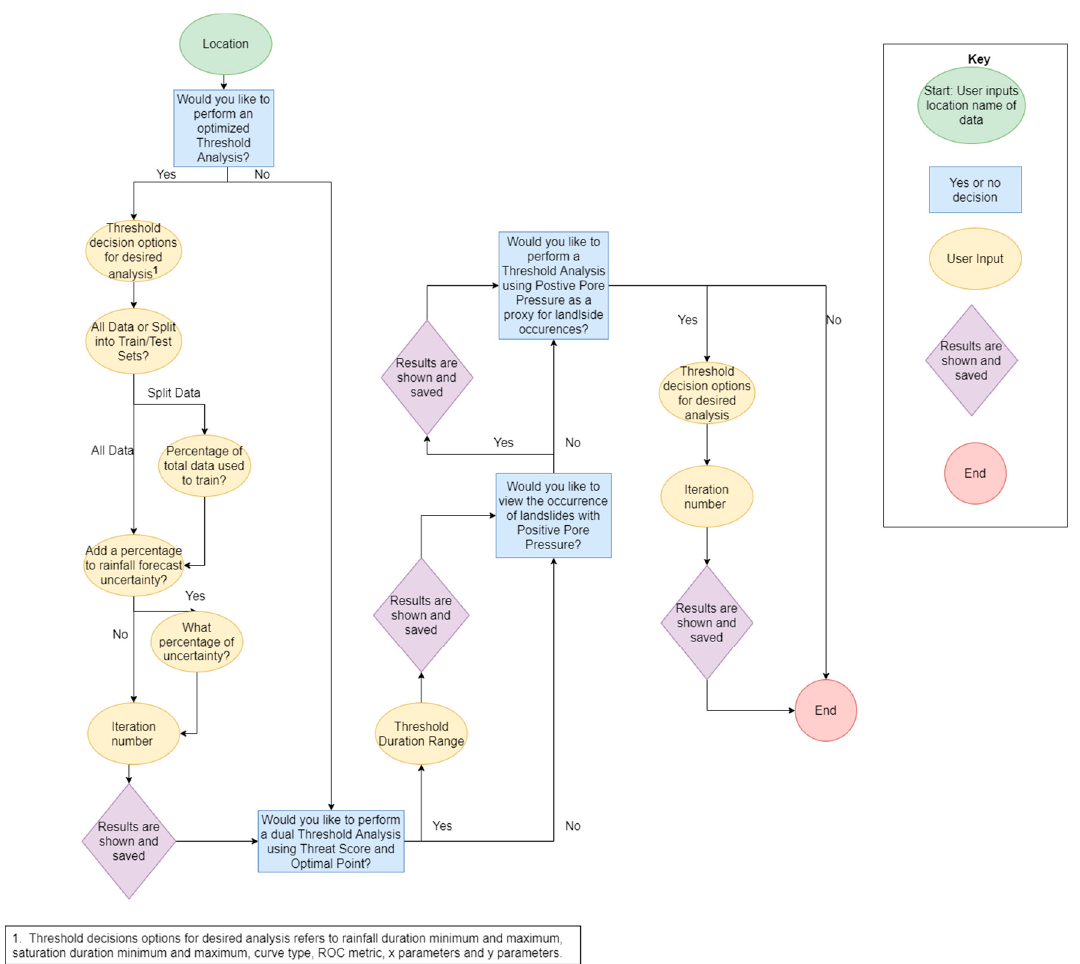
Figure 4. A flowchart of the user options and inputs with the configuration script ConfiHydroMet.py. The configuration script starts with the green circle and moves through the flow chart. If a specific analysis is desired, the user will then input the corresponding values denoted by the yellow ellipses. Once all inputs are selected, the code can be run, and results are shown.